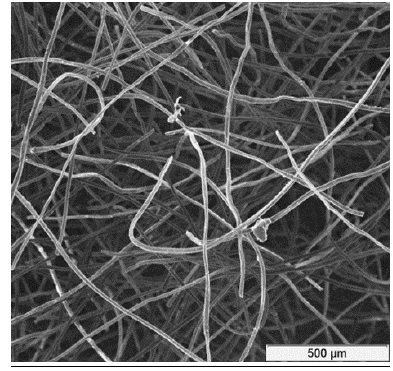
Figure 1. A magnified picture of the CF structure. Table 1. Mechanical properties of CF.